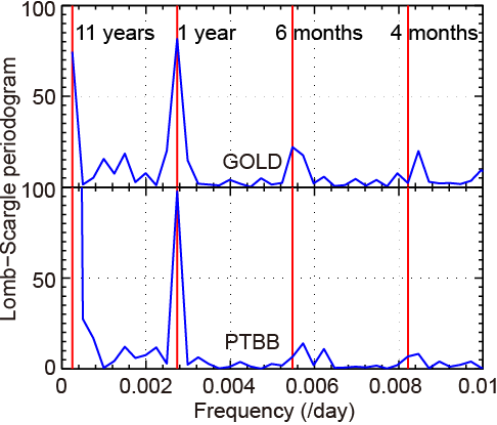
Figure 3. Lomb–Scargle spectra of the daily optimal ionospheric shell height.